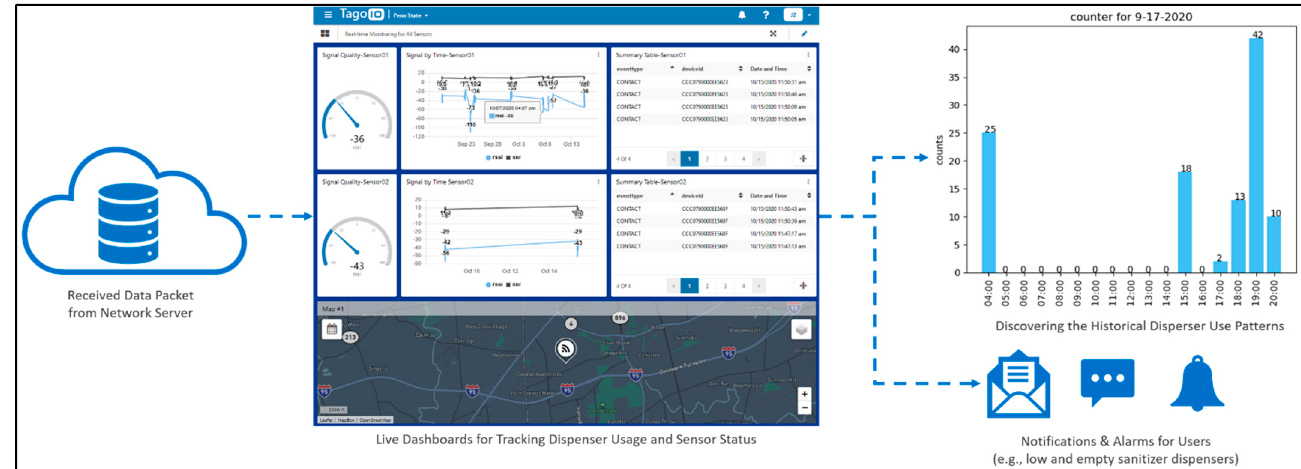
Figure 9. Functions of the application server.